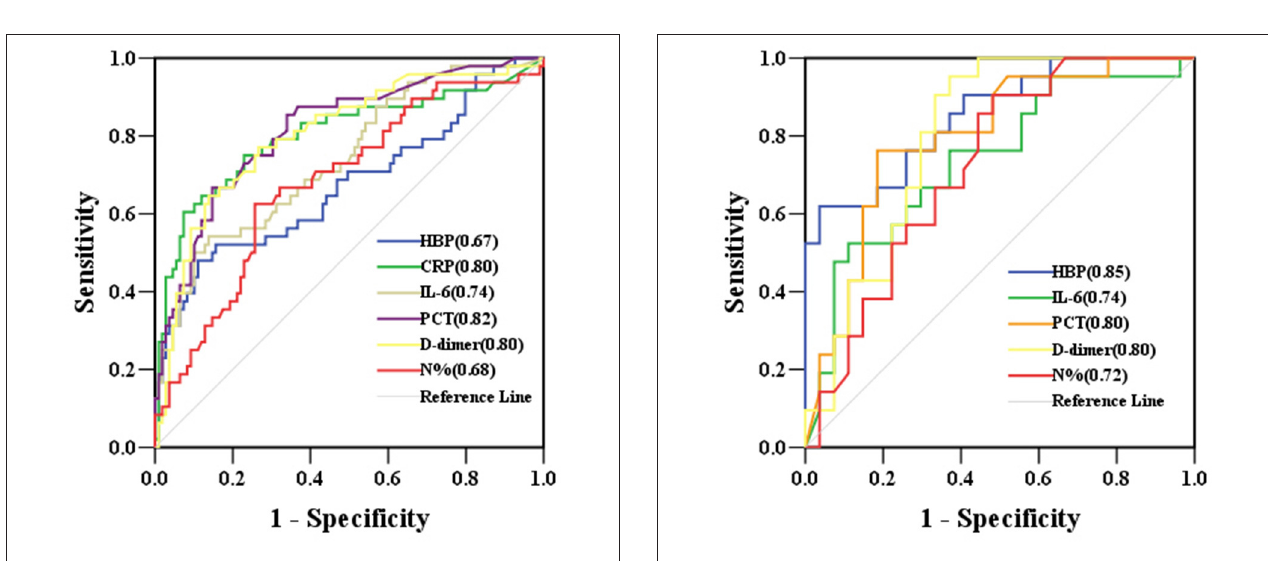
FIGURE 4 | ROC curves for biomarkers predicting the development of severe sepsis in children with sepsis. AUCs are indicated on the graph. AUC, area under the receiver operating characteristic curve; ROC, receiver operating characteristic curve; HBP, heparin-binding protein; IL-6, interleukin-6; PCT, procalcitonin; N%, neutrophil